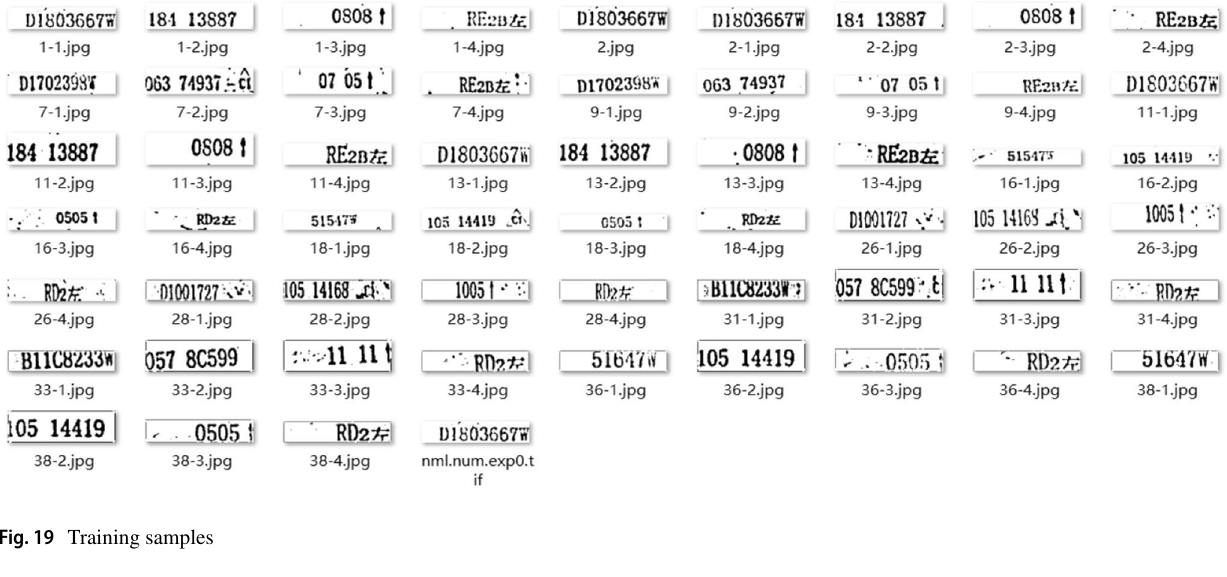
Fig. 19 Training samples Fig. 20 Correction of characters and